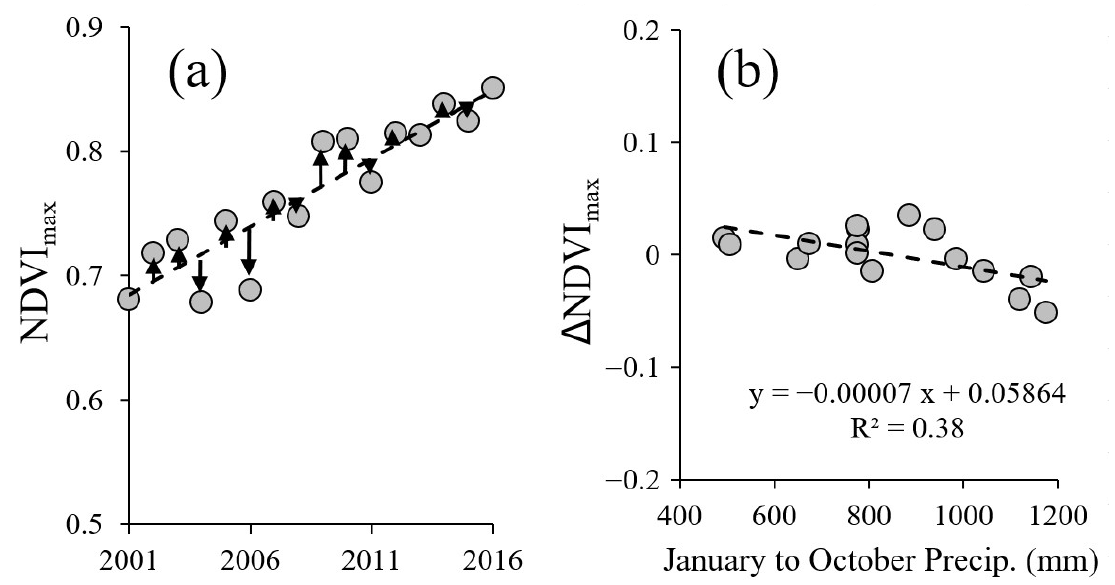
Figure 9. ( a ) Seasonal peak NDVI for monsoon for an average of all sample locations inside the irrigation district, and ( b ) the comparison between January–October precipitation and NDVI differ- ence.